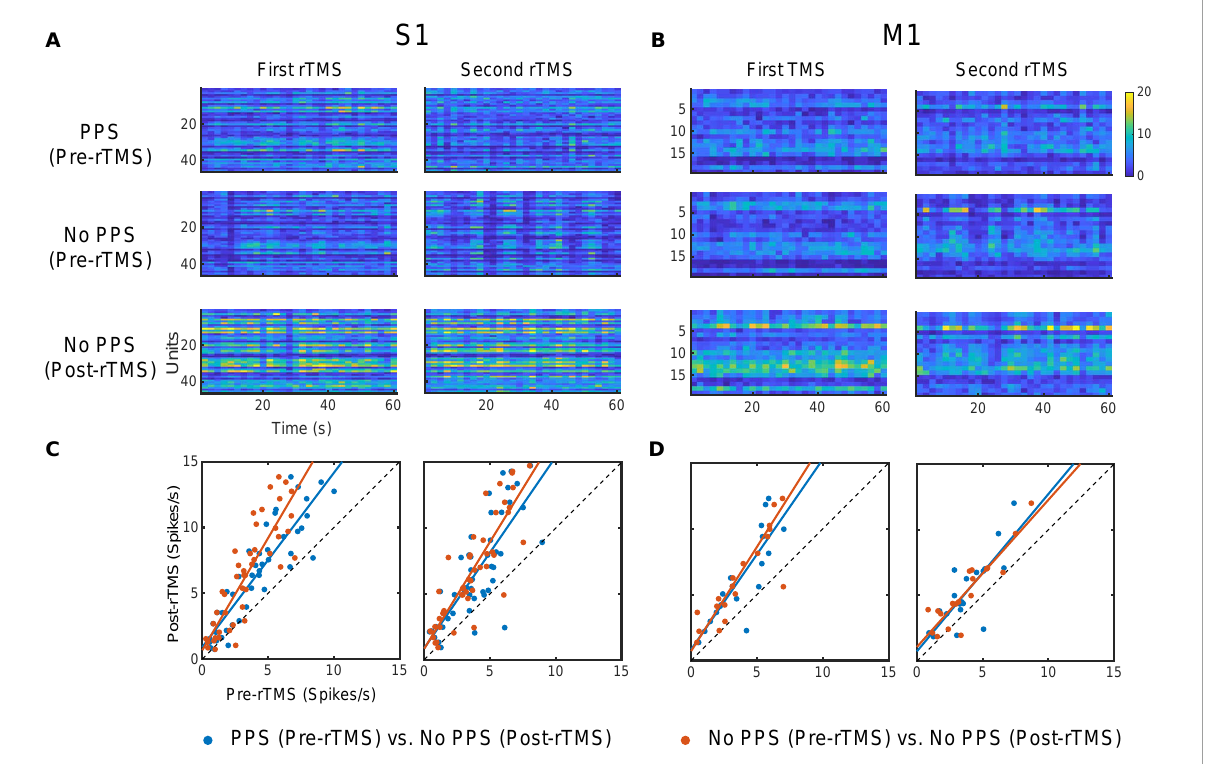
FIGURE13 Comparison of neuronal spike firing rates between pre-rTMS signal during PPS, pre-rTMS signal without PPS, and post-rTMS signal without PPS. (A) Firing rate histograms of S1 neurons ( n = 46, bin size = 2 s) during the three types of signals. (B) Firing rate histograms of M1 neurons ( n = 19, bin size = 2 s) during the three types of signals. (C,D) Scatter plots of firing rates of neurons. Blue: pre-rTMS during PPS vs. post-rTMS without PPS. Red: pre-rTMS without PPS vs. post-rTMS without